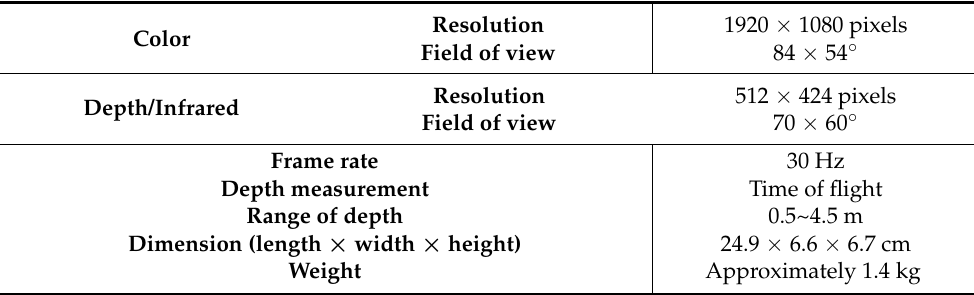
Table 1. Kinect v2 specifications [33] .